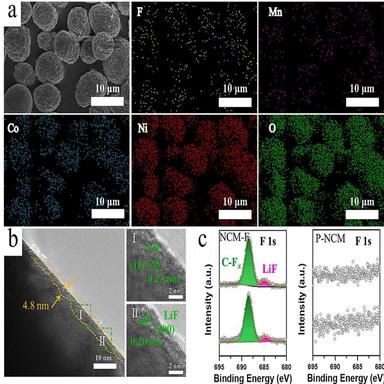
(a) SEM and EDS mapping images of NCM–F. (b) TEM images of NCM–F. (c) F 1 s spectra of NCM-F and P-NCM. Fresh samples are displayed in the top, and the samples exposed in air for 4 weeks are displayed in the bottom.